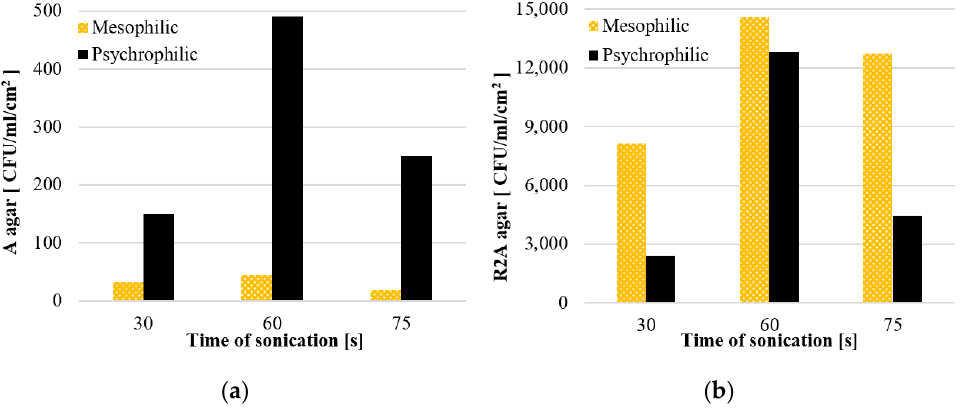
Figure 2. Average number of mesophilic and psychrophilic bacteria on A agar ( a ) and R2A agar ( b ).